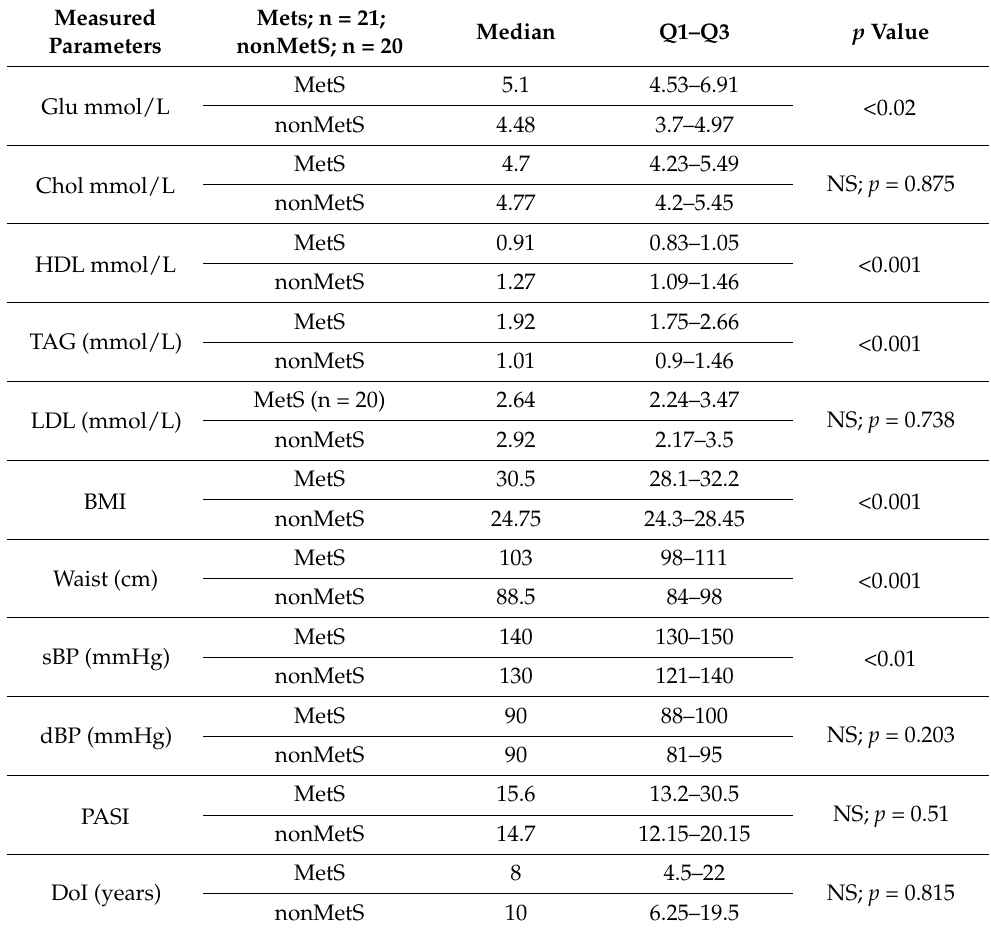
Table 1. Biochemical parameters and parameters associated with MetS and psoriasis.